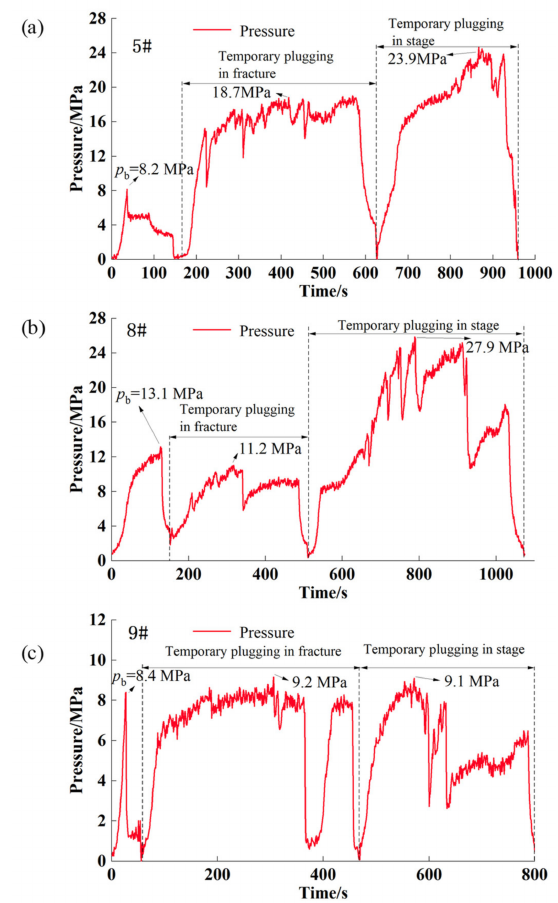
Figure 10. Temporary plugging pressure curve under different number of clusters in a single stage: ( a ) Pressure curve of specimen 5#, ( b ) Pressure curve of specimen 8#, ( c ) Pressure curve of specimen